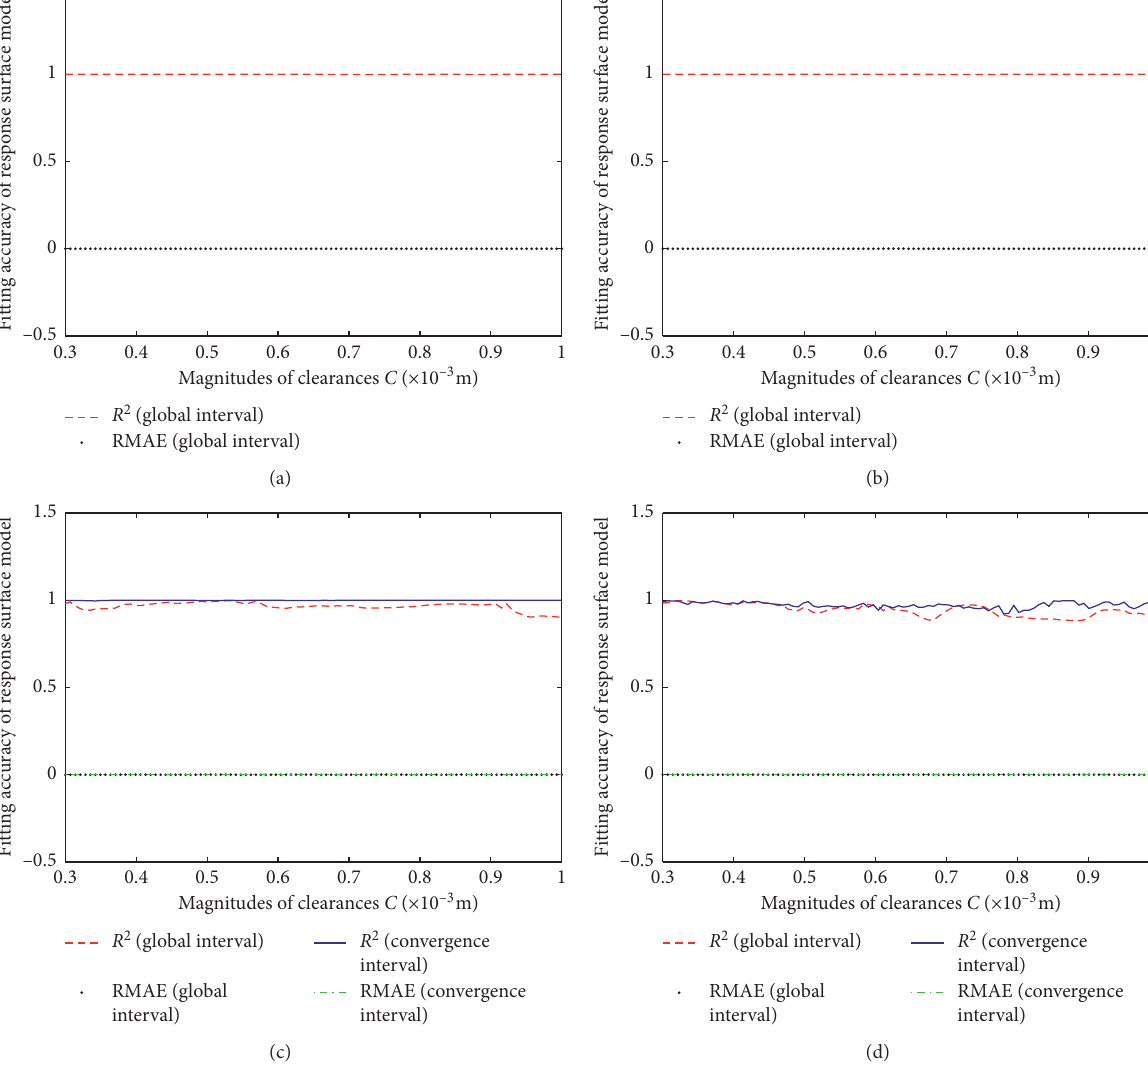
Figure 7: Variation in fitting accuracy of the response surface proxy model with joint clearance magnitude within different variation intervals of design variables: (a) m 1 and m 2 are considered as design variables; (b) m 2 and m 3 are considered as design variables; (c) μ 1 and μ 2 are considered as design variables; (d) I 1 and I 2 are considered as design